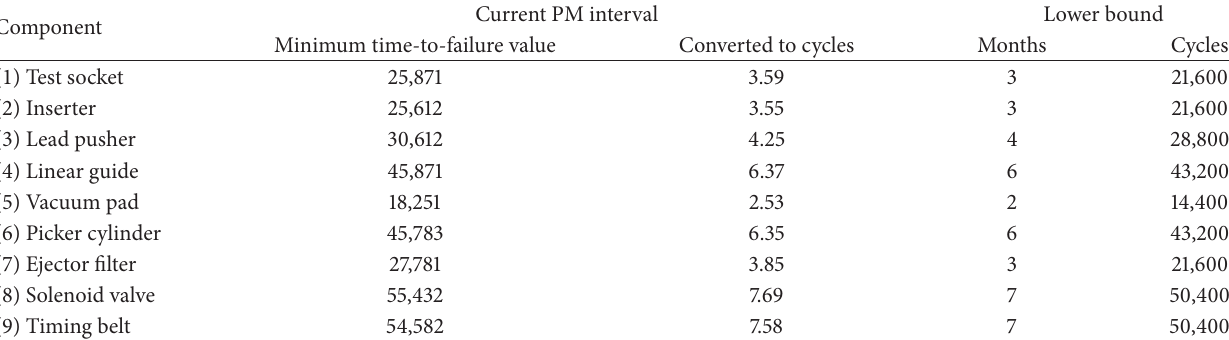
Table 11: Lower bound setting for each component.